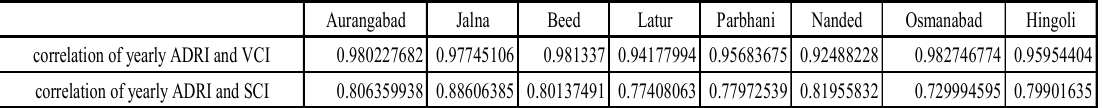
Table 4: Correlation of ADRI with VCI and SCI for 17 years